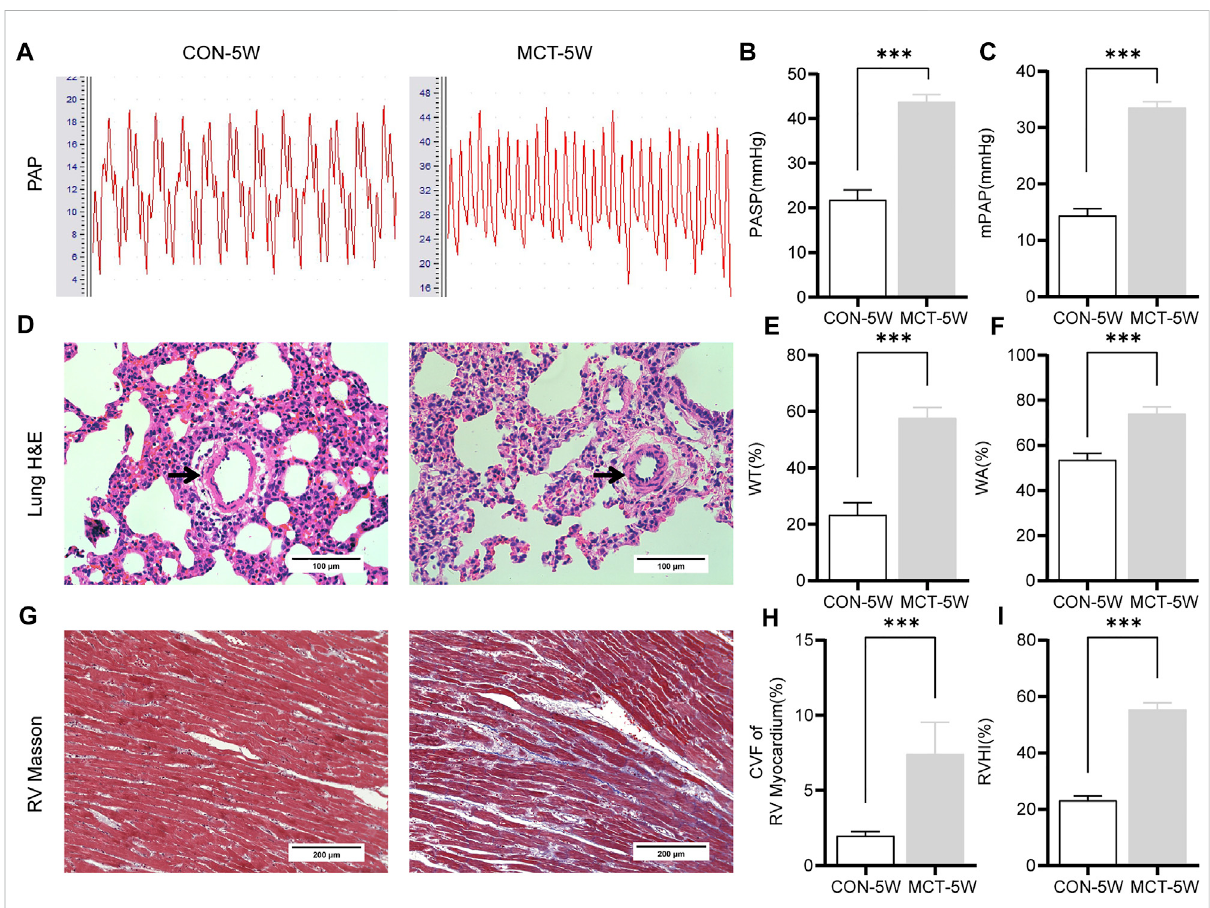
FIGURE 4 MCT-induced PH in rats. (A) Representative pulmonary artery pressure wavaforms obtained from CON-5W and MCT-5W rats. (B) Pulmonary artery systolic pressure was measured in CON-5W and MCT-5W rats. (C) Mean pulmonary artery pressure was measured in CON-5W and MCT-5W rats. (D) Representativeimages(×400originalmagni fi cation)ofH&Estainingoflung tissuesfromCON-5W andMCT-5Wrats. Blackarrowpointsto pulmonary arteriole (20 – 100 μ m in diameter). (E) Quantitative analysis of vascular wall thickness (F) Quantitative analysis of vascular wall area (G) Representativeimages(×200originalmagni fi cation)ofMasson ’ strichromestainingofRVtissuesfromCON-5W andMCT-5Wrats.Redindicates muscle fi bers; blue indicates collagen fi bers. (H) Quantitative analysis of fi brotic area (I) Quantitative analysis of right ventricular hypertrophy index. Valuesarepresentedas Mean±SD.Data(CON-5W, n =10;MCT-5W, n =9)wereanalyzed byunpaired Student ’ st-test.*** p < 0.001.Abbreviations: PASP,pulmonaryarterysystolicpressure;mPAP,meanpulmonaryarterypressure;H&E,hematoxylin-eosin;WT,pulmonaryarteriolewallthickness; WA, pulmonary arteriole wall area; CVF, collagen volume fraction; RVHI, right ventricular hypertrophy index.